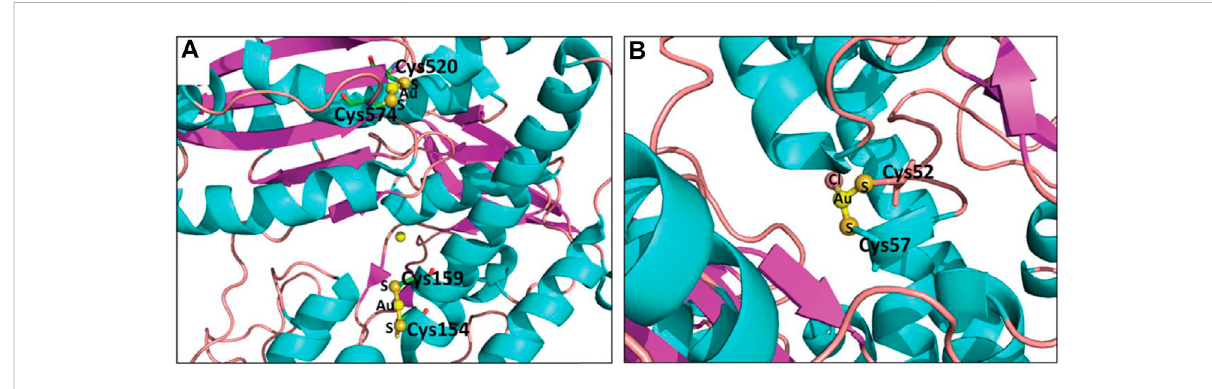
FIGURE 2 Crystal structure of gold(I)-protein conjugates: (A) Au(I)-TGR conjugates (PDB code: 3H4K, gold source: aurano fi n). (B) Au(I)-TR conjugates (PDB code: 2YAU, gold source: aurano fi n). Reproduced with permission (Bellelli et al., 2009; Colotti et al.,